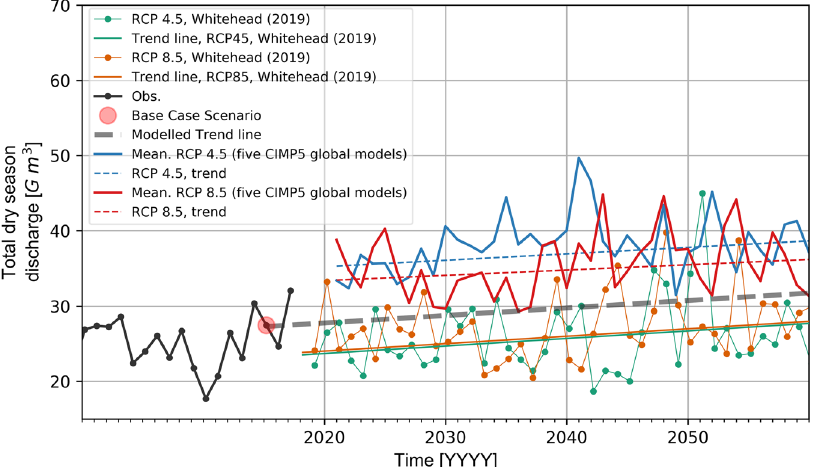
Fig. 7 Projections of the Mekong River discharge in the next three decades. Observed and projected cumulative dry season discharge in Kratie from various sources for two RCP 4.5 and RCP 8.5 scenarios 94 .